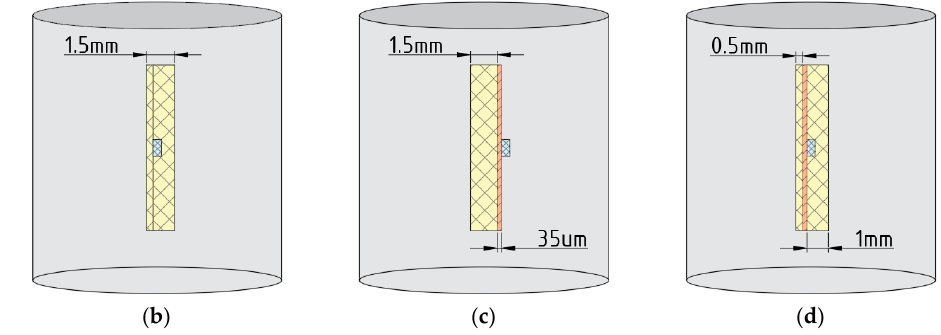
Figure 6. Heat distribution on the surface of the fiberglass base in the simulation model.